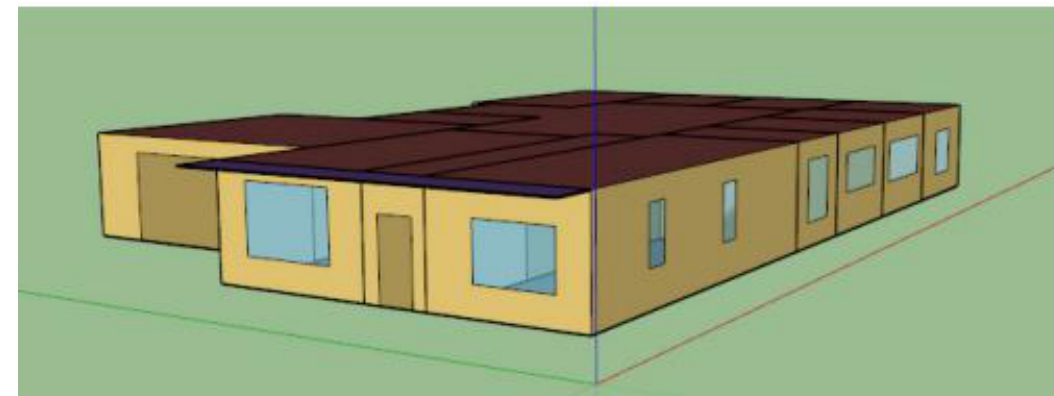
Figure 3. Zero energy house designed in Google SketchUp [2]